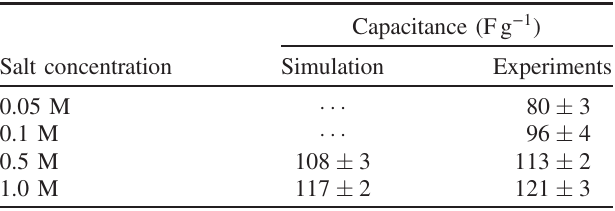
TABLE I. Electrode capacitance (in F g − 1 ) from molecular simulations and experiments. Note that the simulations cannot be performed for the lower